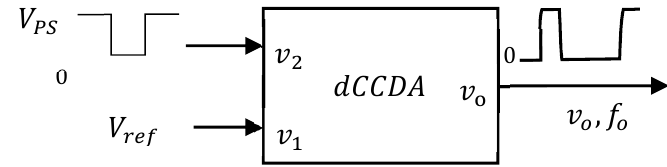
Figure 11. Block diagram of the